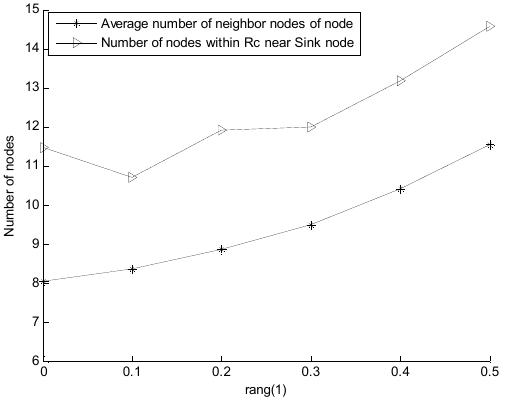
Figure 11. Network reliability of URSA for varying rang .